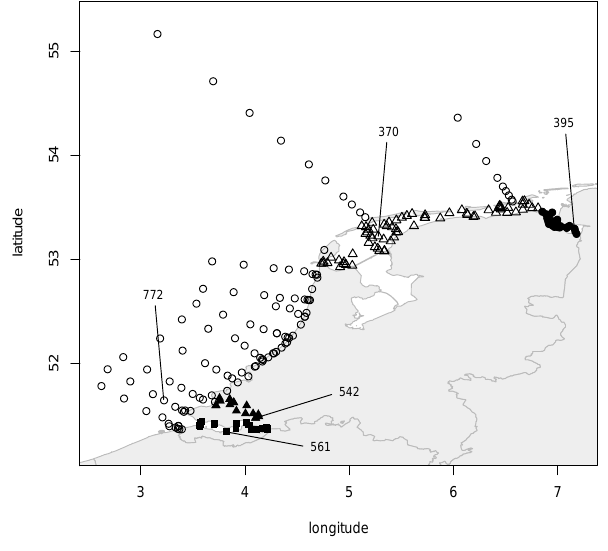
Fig. 1. Map showing all sampling locations of the MWTL dataset. Five geographical areas are distinguished: North Sea ( ◦ ), Wadden Sea ( 4 ), Eastern Scheldt ( N ), Western Scheldt ( (cid:4) ) and Ems-Dollard ( • ). Numbers indicate the stations which have been selected for presentation in full